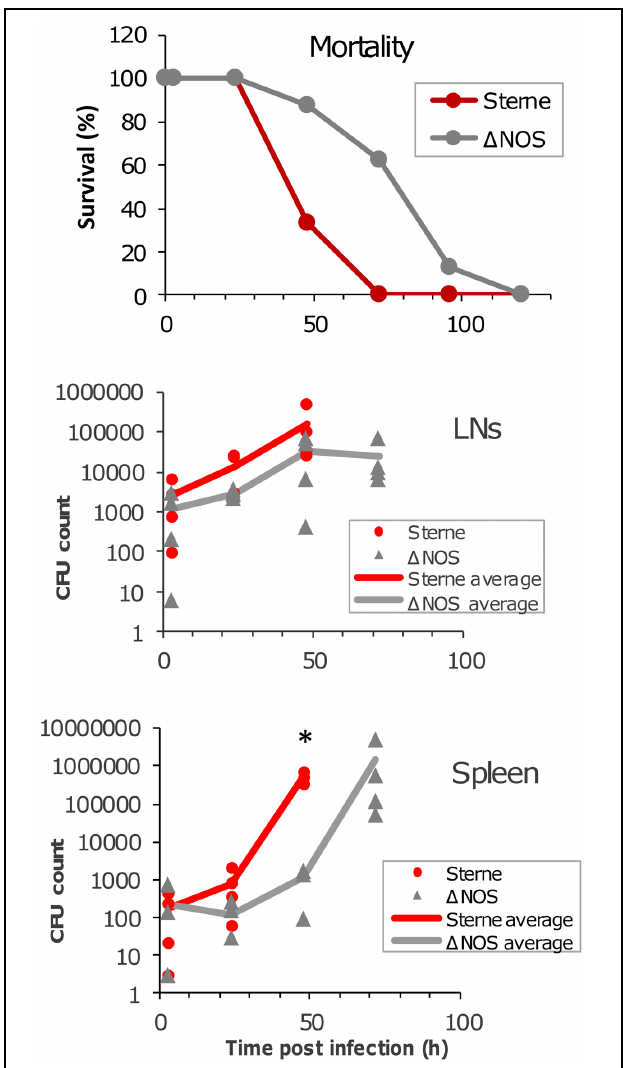
FIGURE 5 | Mortality curves and bacterial load in LNs and the spleen of spore-challenged DBA/2J mice. Animals were challenged with the toxinogenic, non-encapsulated Bacillus anthracis Sterne 34F2 or (cid:2) NOS knockout Sterne spores (4 × 10 6 spores in 20 μ l of PBS), intradermally into both hind footpads. Twenty animals were used for each strain to obtain the mortality curves. Four animals were euthanized at each time point to determine a bacterial load in the LNs and spleen. The organs were surgically removed and homogenized. The homogenates were seeded onto agar plates to determine the number of colony-forming units (CFUs). The CFU values are shown for each animal, and the lines in the panels are drawn through the average CFU values for each time point. A statistically reliable difference ( t -test, p < 0.001) between Sterne and (cid:2) NOS in the spleen at 48 h post challenge is indicated by an asterisk.